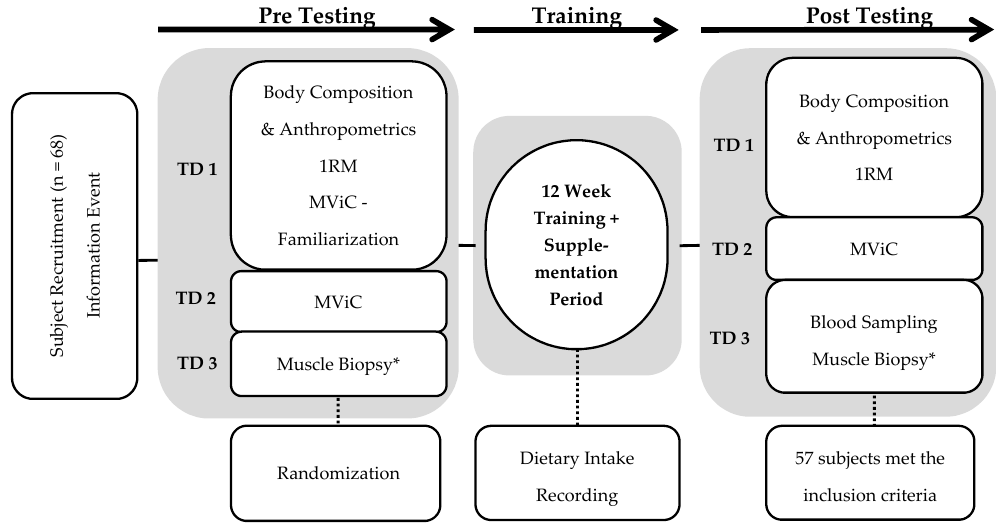
Figure 1. Study intervention overview: TD = testing day; 1RM = one-repetition maximum; MViC = maximal voluntary isometric contraction; * = Muscle Biopsies were only taken in Phase 1.